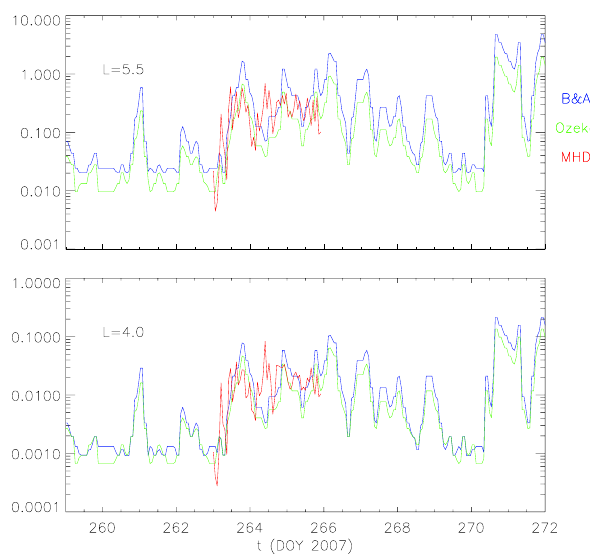
Figure 9. Time-dependent radial diffusion coefficients, evaluated at L ∗ 5 . 5 and L ∗ = 4 . 0, according to the empirical models of Brautigam and Albert (2000) (blue curves) and Ozeke et al. (2014) (green curves), and an MHD simulation (Elkington et al., 2012) (red curves), as described in the text.